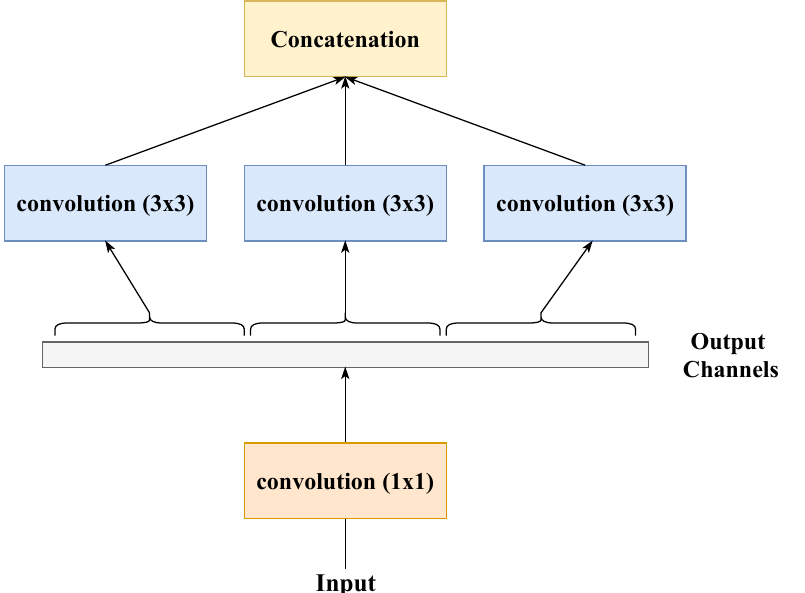
Figure 5. A schematic diagram representing a simplified inception block. Compared to Figure 4, it only contains a single size of convolutions (3 × 3) and does not contain pooling layers. (Chollet [23]).